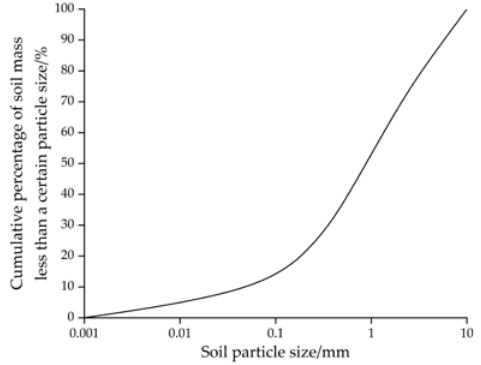
Figure 1. Particle size distribution curve of shield mud.